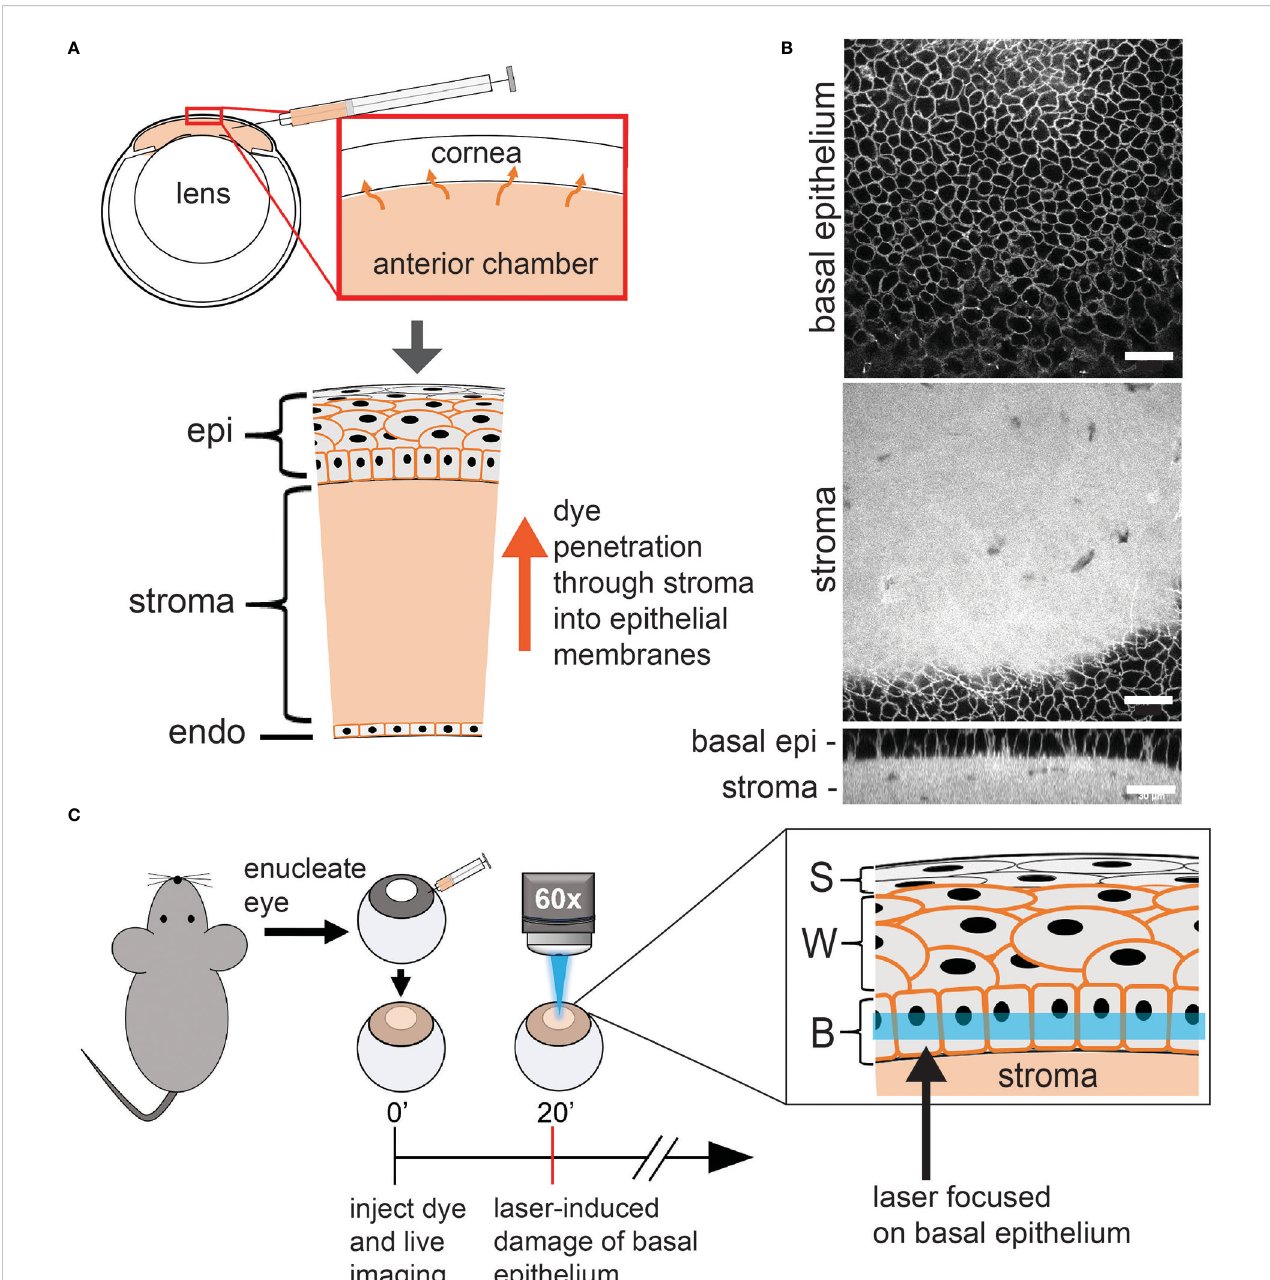
FIGURE 1 Overview of the confocal laser scanning microscopy induction of basal epithelium microdamage. (A) Schematic of cornea and anterior chamber injection. Alexa 647 hydrazide and either SGC5 or FM4-64 (orange in diagram) injected into the anterior chamber, readily diffuses into the cell membranes of all corneal layer. SGC5 and FM4-64 labelled cell membranes while Alexa647 hydrazide was con fi ned to the stroma. (B) Confocal microscope imaging of SGC5 labelling in cell membranes of the corneal basal epithelium and stroma. (C) Corneal basal epithelium laser-damage protocol. Eyes from euthanized mice were enucleated, injected with dye, bathed in brain buffer and a de fi ned region of cornea imaged at high laser power for 1-10 minutes. epi, corneal epithelium; (b) epi, basal epithelium; S, super fi cial epithelium; W, wing cells; B, basal epithelium. Scale bar in B =